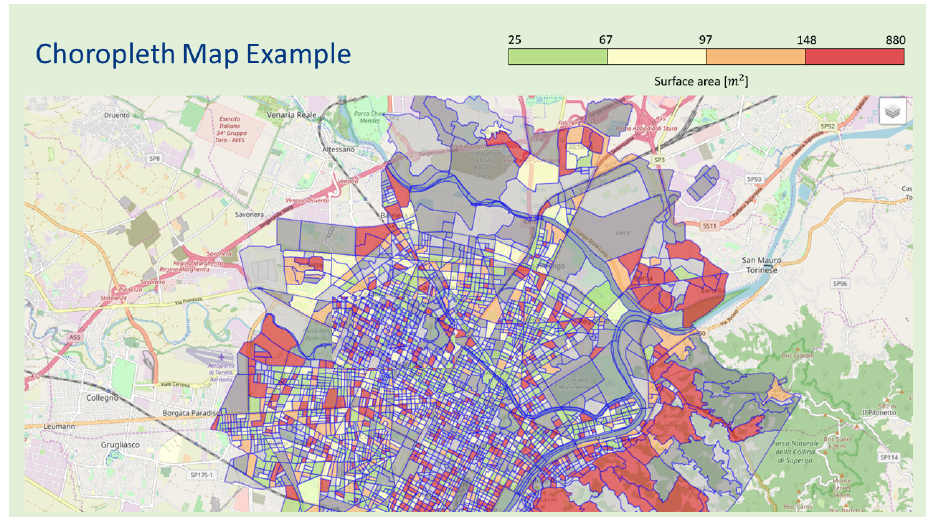
Figure 13. Example of choropleth map for the surface area feature.